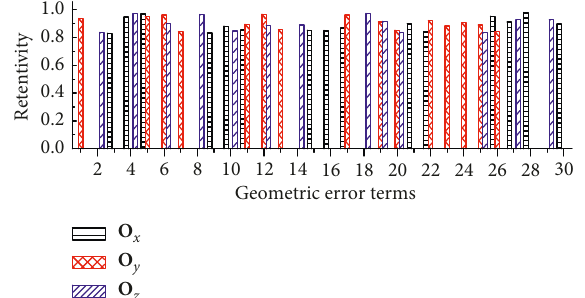
Figure 8: Accuracy retentivity analysis for the orientation vector at t 3 . Table 4: Analysis results of geometric accuracy retentivity. Measurement